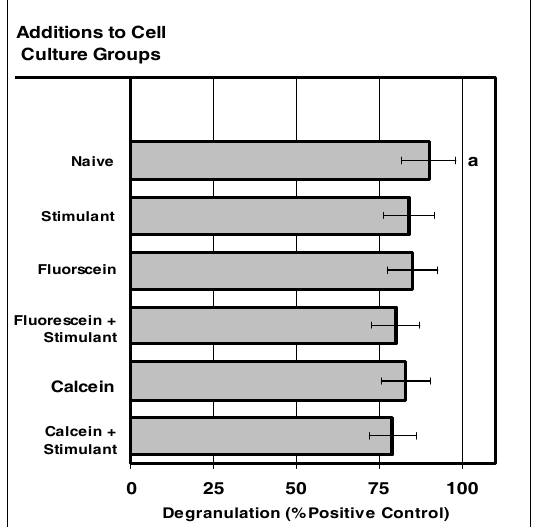
Figure 5: Internalization of VIS micro-sensor dyes did not alter neutrophil degranulation in response to stimuli.